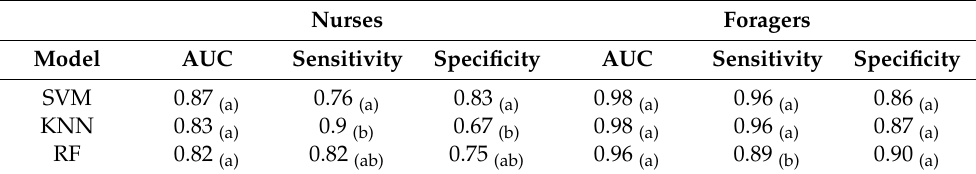
Figure 1. Nurses’ data. ( A ) Relation between the mean Accuracy of the model obtained with the nurse training dataset (assessed through Repeated Cross-Validation) and the number of variables used. ( B ) Three-dimensional plot showing the relation between the intensity values of the three most informative variables and the nurse category in the training dataset. ( C ) ROC curve computed with the prediction of the RF model on the nurse test dataset. ( D ) Four-fold plot showing the results of the confusion matrix produced with the prediction of the RF model on the nurse test dataset. Table 1. Performances of the models assessed through resampling on the training dataset.